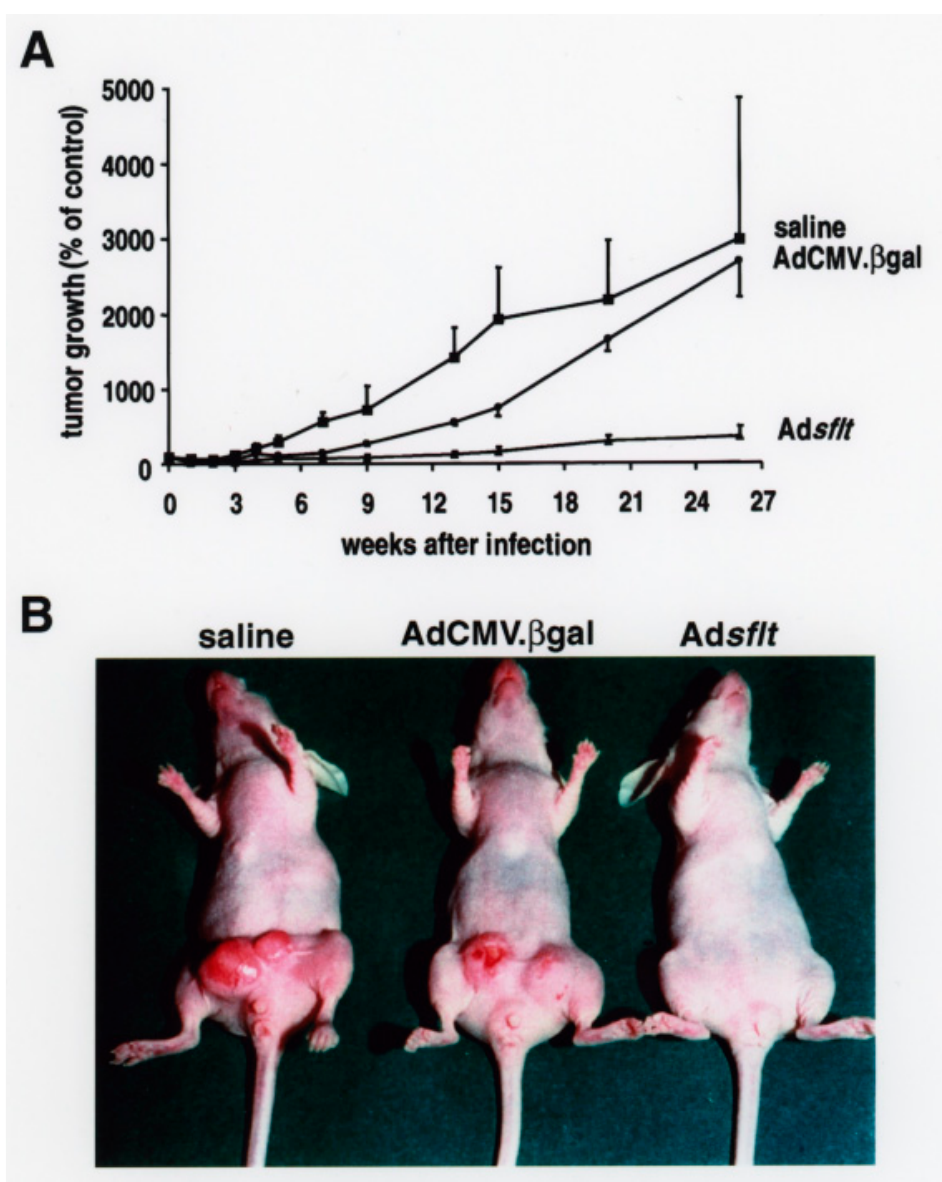
Figure 2. Effect of Ad sflt single injection on MCF-7 tumor growth in nude mice. ( A ) Inhibition of mammary tumor growth after a single administration of Ad sflt vector. Well-established breast tumors arising from orthotopically implanted MCF-7 cells (1 × 10 6 ) were injected (day 0) with Ad sflt (2 × 10 9 pfu/50 µ L) (triangles), AdCMV. β gal (2 × 10 9 pfu/50 µ L) (circles) or with saline solution (50 µ L) (squares). Tumor volume was measured weekly with calipers; at each time point the volume of a single tumor was expressed as the percentage of the volume of the same tumor (100%), considered as reference at day 0. Data are presented as mean % ± SE (saline n = 6; AdCMV. β gal n = 14; Ad sflt n = 15). As noted in Methods, statistical analysis was performed by two-way analysis of variance using the Student–Newman–Keuls Test for pairwise multiple comparison of tumor volumes. The results showed a slight inhibition of tumor growth in Ad sflt -treated tumors compared to saline- treated tumors 7 weeks post-injection ( p < 0.05) and a marked decrease of tumor size in Ad sflt -treated tumors compared to saline-treated and AdCMV. β gal-injected tumors from week 9 onward (Ad sflt vs. saline, p < 0.05; Ad sflt vs. AdCMV. β gal, p < 0.05; AdCMV. β gal vs. saline, p < 0.05). ( B ) Representative macroscopic photographs of saline-, AdCMV. β gal- and Ad sflt -treated tumors 26 weeks after a single injection in nude mice. While control breast tumors reached a remarkable volume and were often ulcerated, Ad sflt -treated tumors regressed to a non-measurable